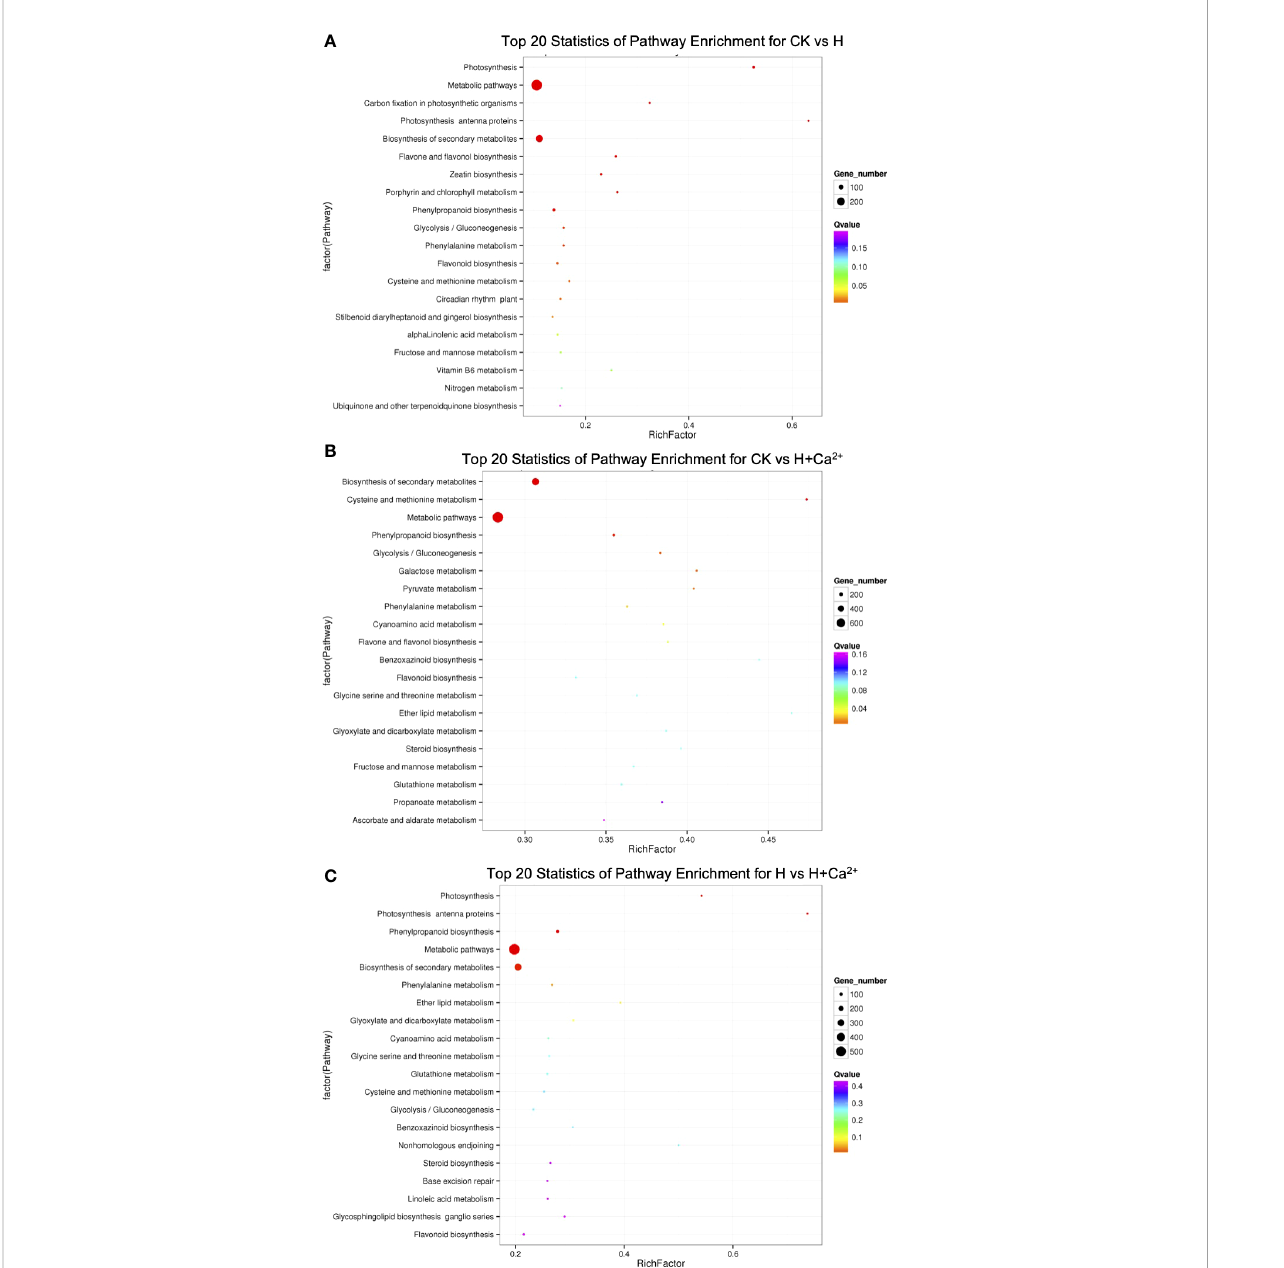
FIGURE 3 KEGG pathway enrichment analysis. The x-axis represented the rich factor, and the y-axis indicated the enriched KEGG pathway. (A) CK vs H (control treatment compared with hypoxic treatment), (B) CK vs H + Ca 2+ (control treatment compared with hypoxia + CaCl 2 treatment), (C) H vs H + Ca 2+ (hypoxic treatment compared with hypoxia + CaCl 2